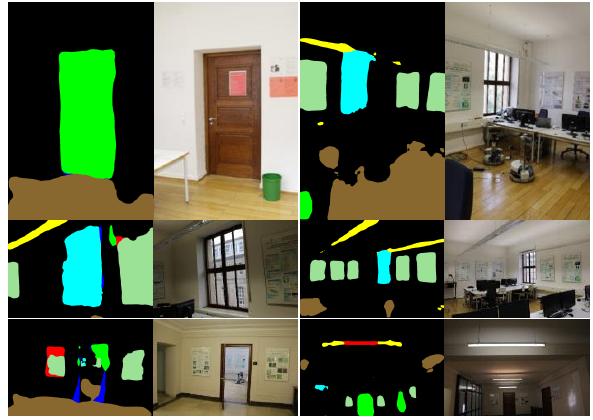
Figure 6. Comparison between a selection of the segmentation results and the related original images. Most of the segmentation results are very good. Some problems like incorrect classification on mostly the edges, wavy lines and rounded corners, missing objects and errors determining the state of the door can